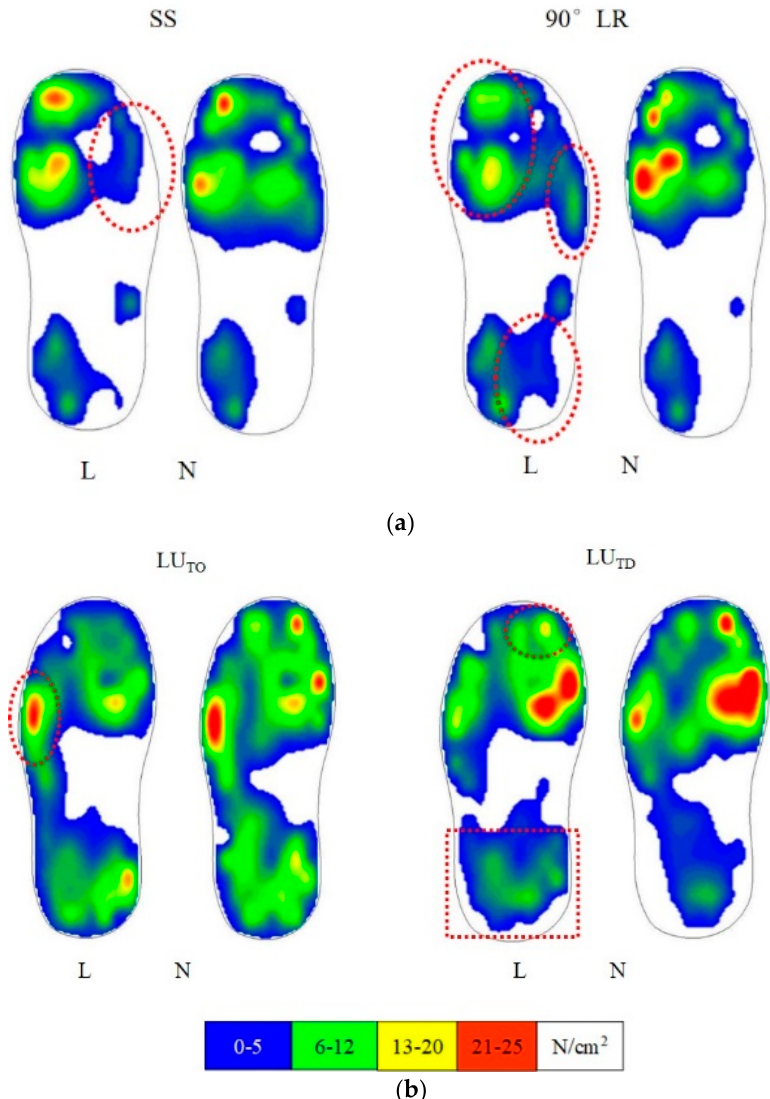
Figure 5. ( a ) E ff ect of di ff erent basketball shoes (L vs. N) on plantar pressure distribution during side-step cutting (SS) and 90 ◦ L-direction running (90 ◦ LR) maneuvers; ( b ) e ff ect of di ff erent basketball shoes (L vs. N) on plantar pressure distribution during lay-up toe-o ff (LU TO ), and lay-up touch-down (LU TD ) maneuvers. Di ff erent colors represented di ff erent pressure values. The pressure values from small to large were blue, green, yellow and red.